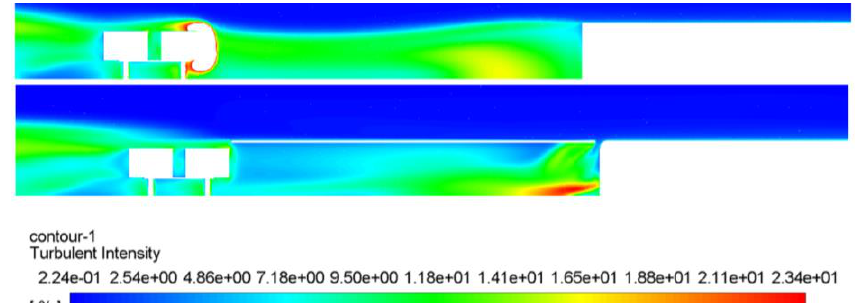
Fig. 19. Plan view comparison of the turbulent intensity of the flow between Concept Two – Revision B (top), and Concept Two – Revision C (bottom).